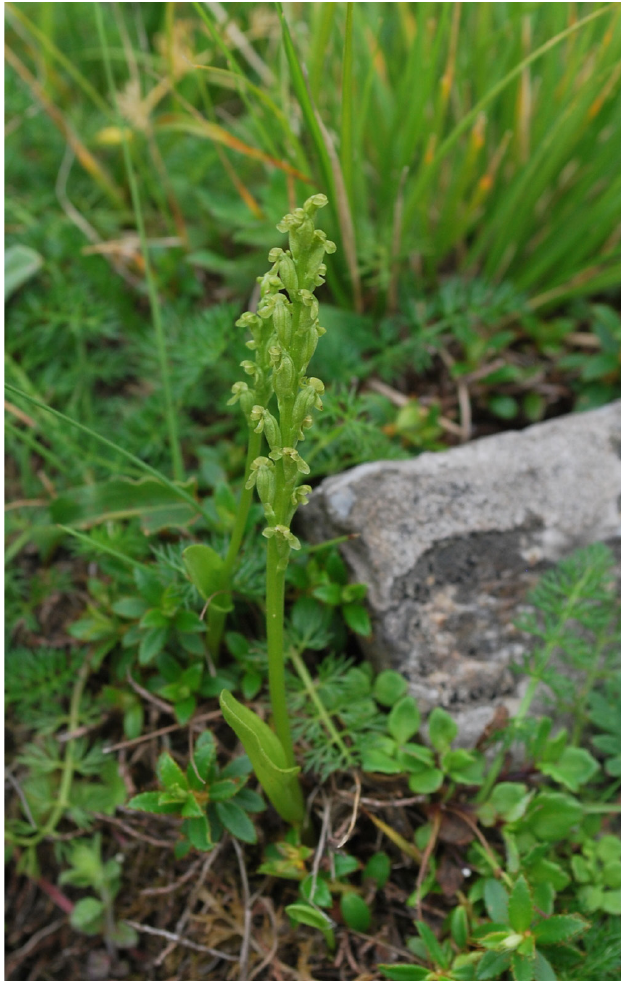
Figure 2. Androcorys pugioniformis